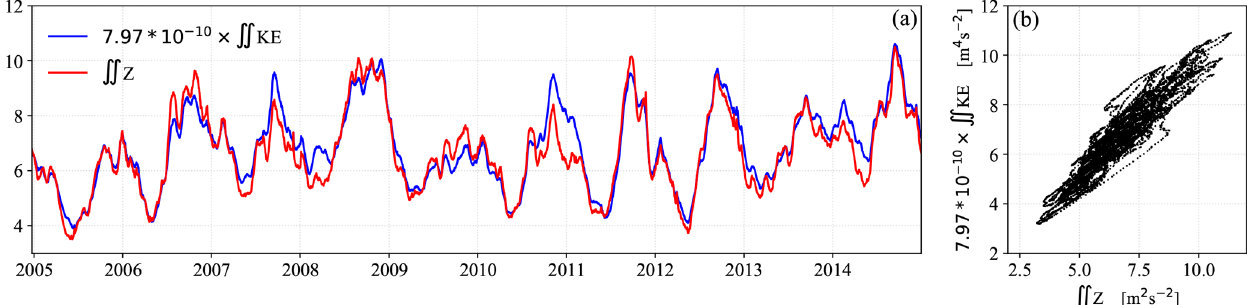
Figure 3. (a) The 10 years of daily values for total enstrophy (red) and rescaled total kinetic energy (blue) integrated over the offshore region (westward from 125.0 ◦ W longitude; see Fig. 4) and (b) correlation plot of the two quantities. The rescaling factor for the kinetic energy integral is 7 . 97 × 10 − 10 (see text).